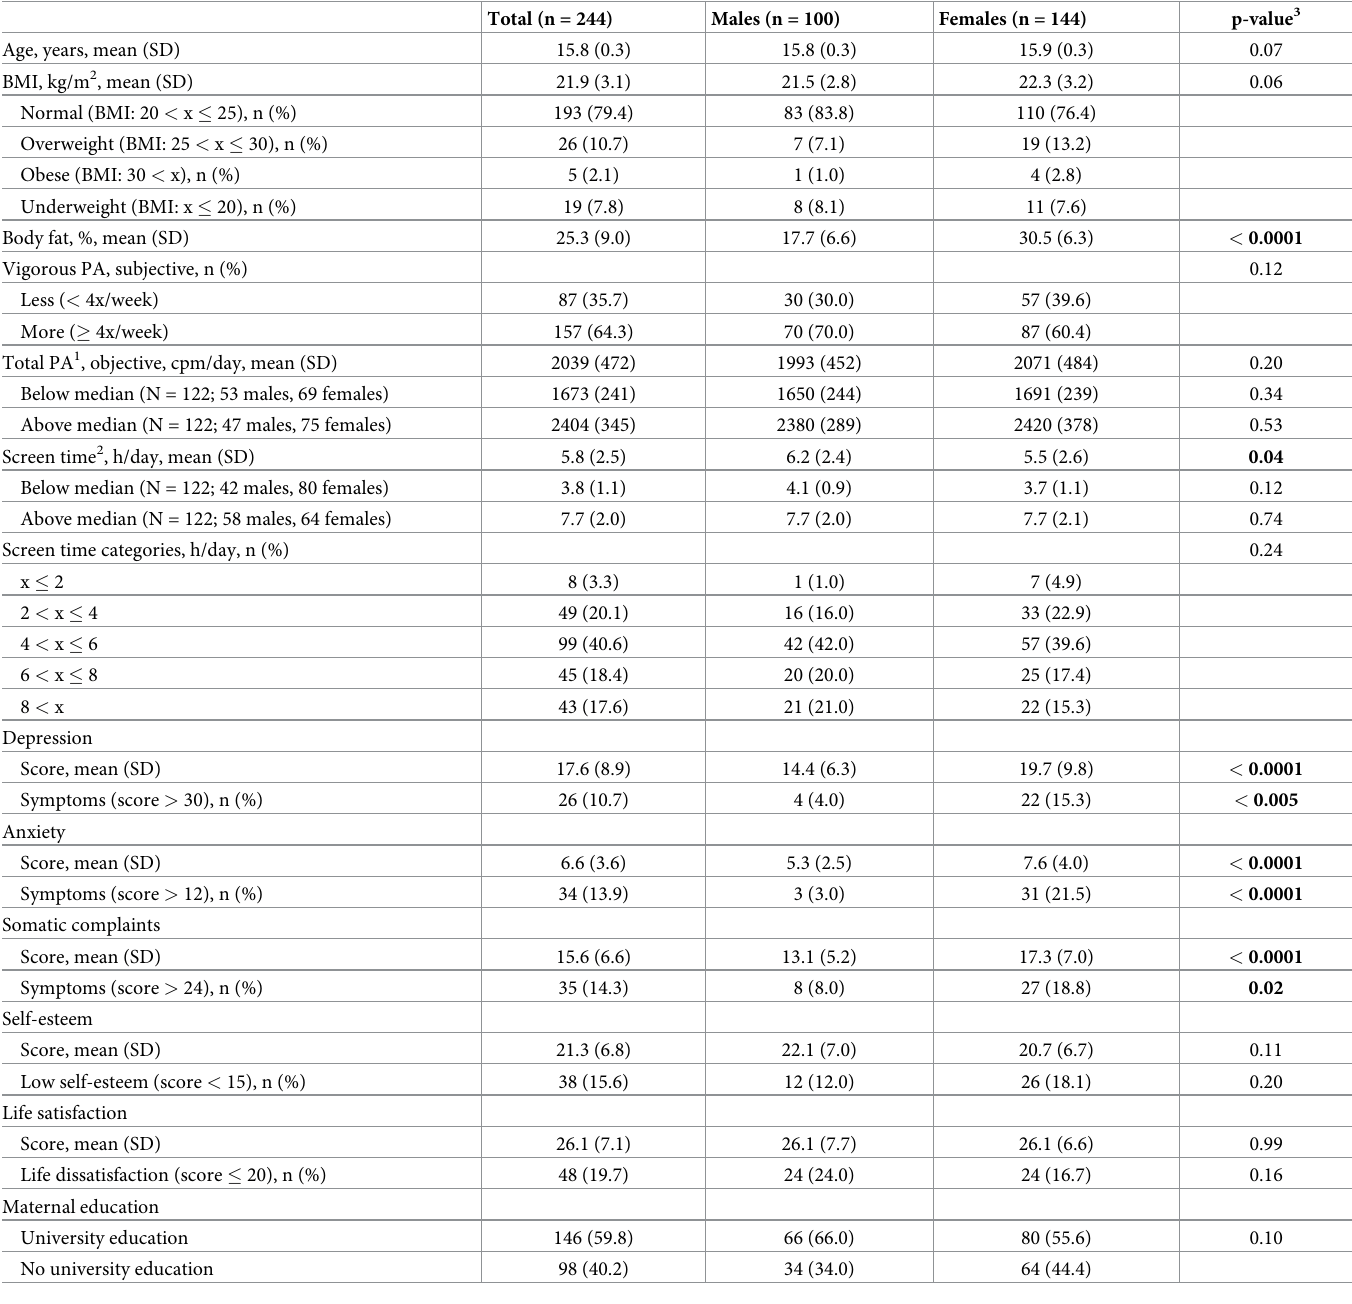
Table 1. Characteristics of the study